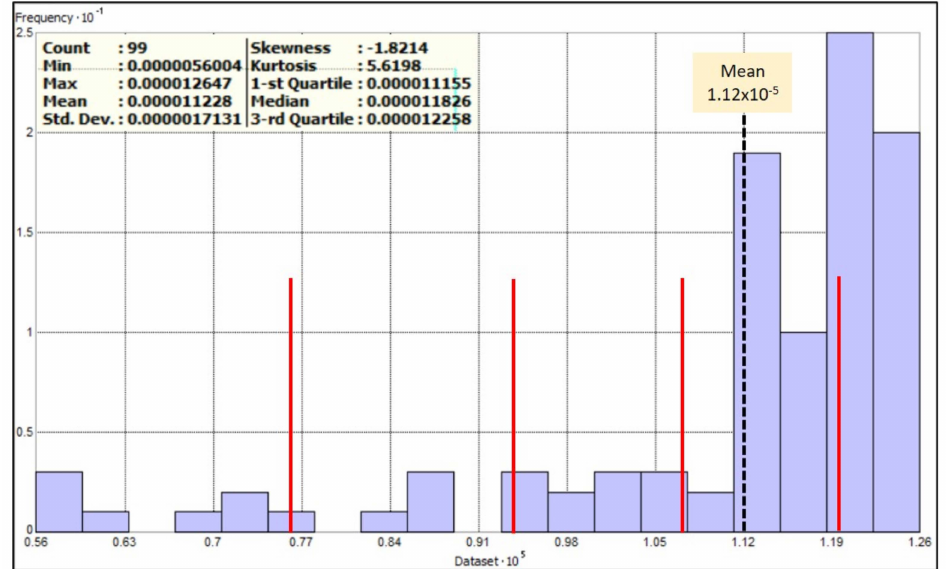
Figure 6. 2SFCA results histogram of MOH healthcare centers. Note: (1) districts with a score of 0 were excluded from the results, and (2) the red lines are the classification